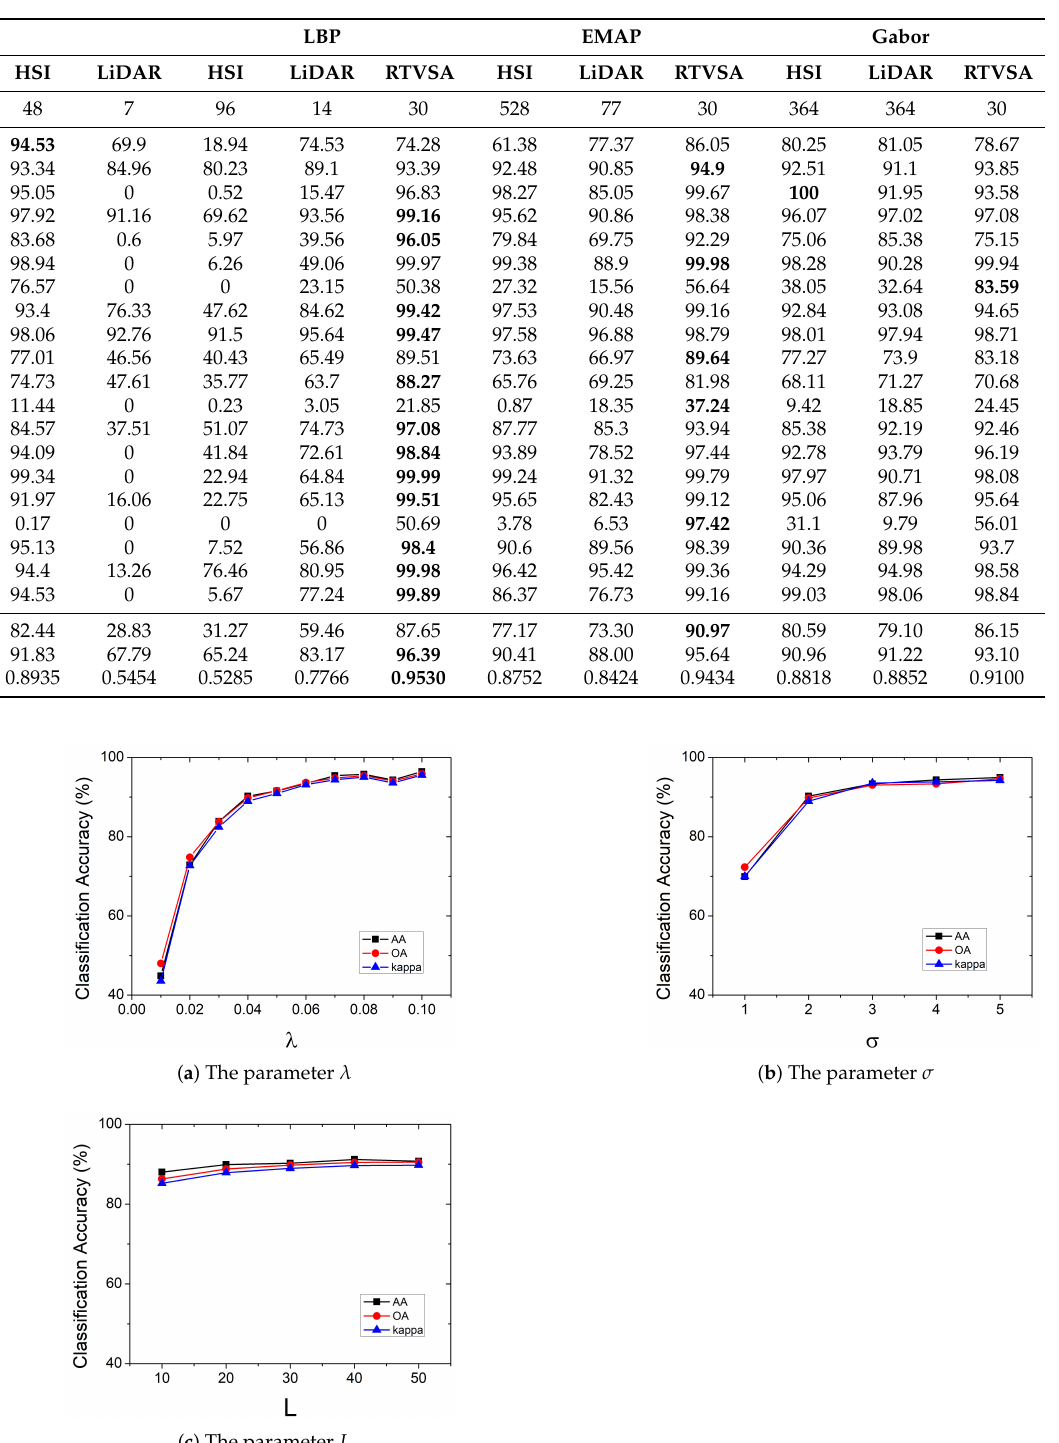
Table 5. The CNN classification performance of the proposed method based on the LBP, EMAP, and Gabor feature extraction on the 2017 Houston dataset (%). The best values are shown in bold.